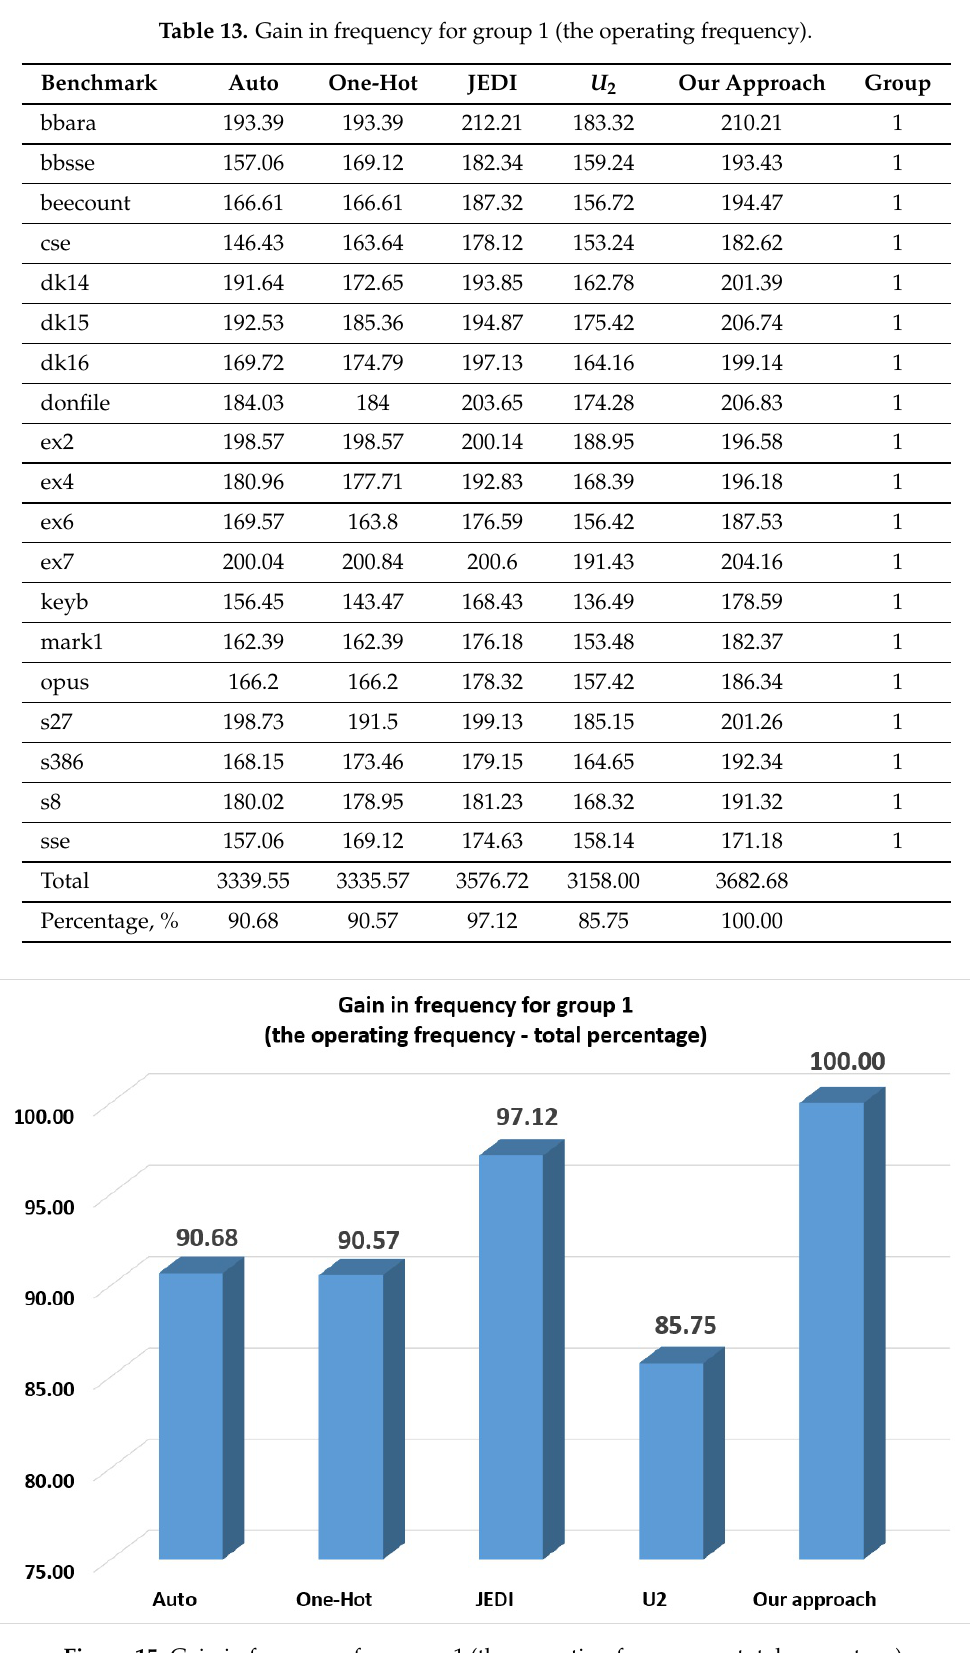
Figure 15. Gain in frequency for group 1 (the operating frequency—total